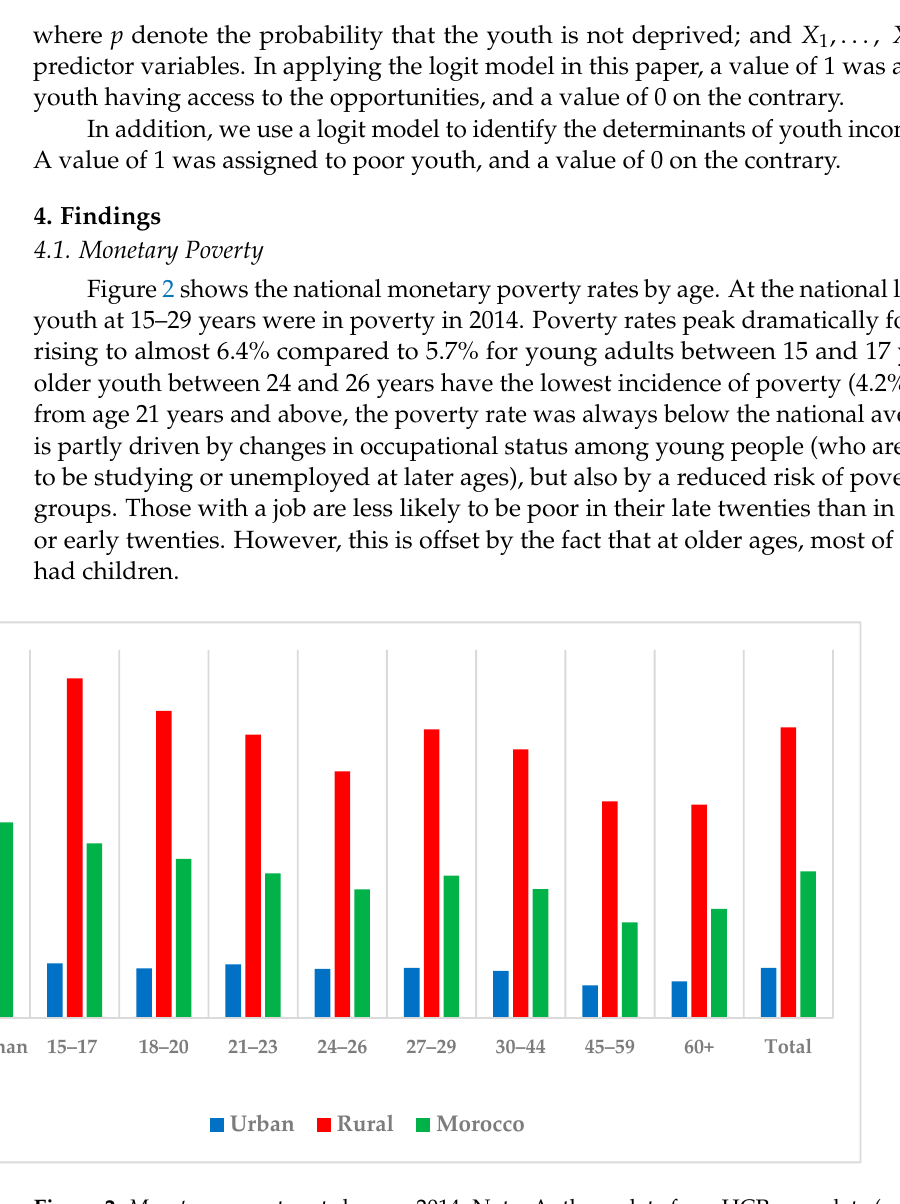
Figure 2. Monetary poverty rate by age, 2014 . Note: Authors, data from HCP open data (www.hcp.ma) (accessed on 1 April 2022).